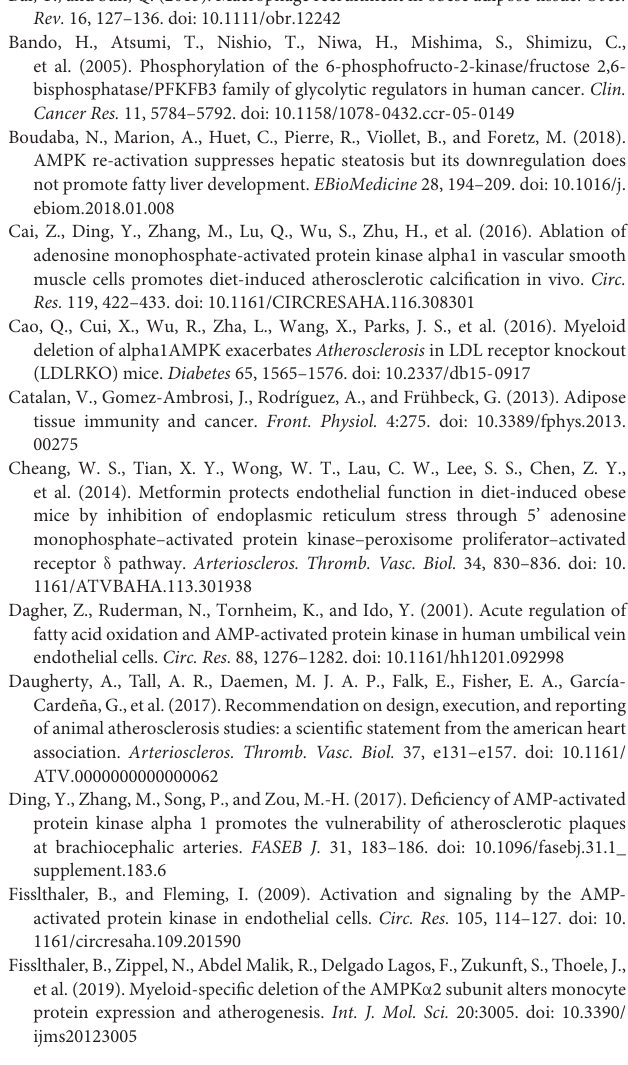
Supplementary Figure 4 | (A) Representative images and quantification of MCP-1-induced migration in BMDMs cultured from Prkaa1 WT and Prkaa1 (cid:49) M ϕ mice in normal and high glucose conditions (NG: 5.5 mM, HG: 30 mM). n = 8, Scale bars, 100 µ m. (B) Quantification data and representative images of flow